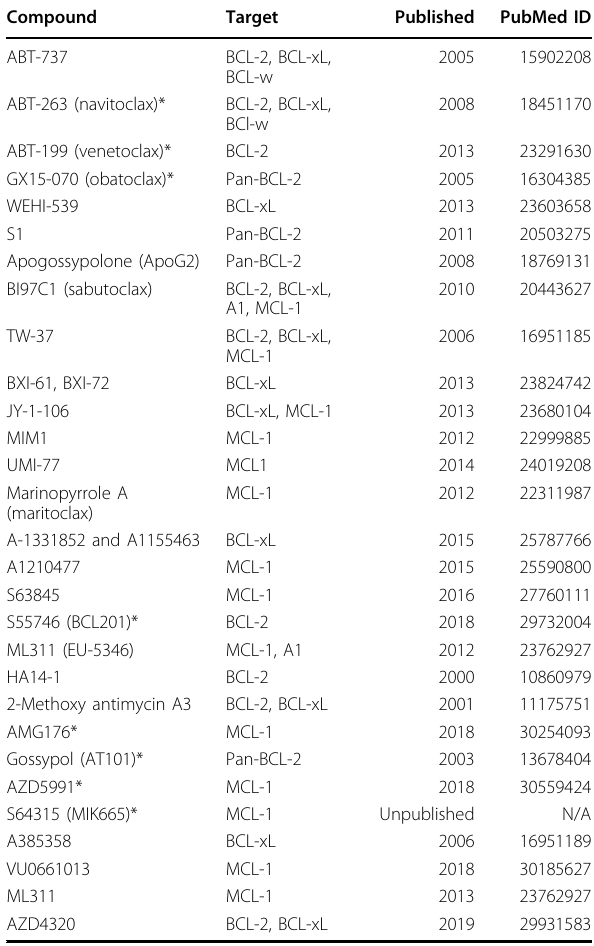
Table 1 Currently commercially available BH3 mimetics and related compounds are known to have been investigated in the context of hematological malignancies, with those in current and/or previous clinical trials for leukemias denoted with an asterisk